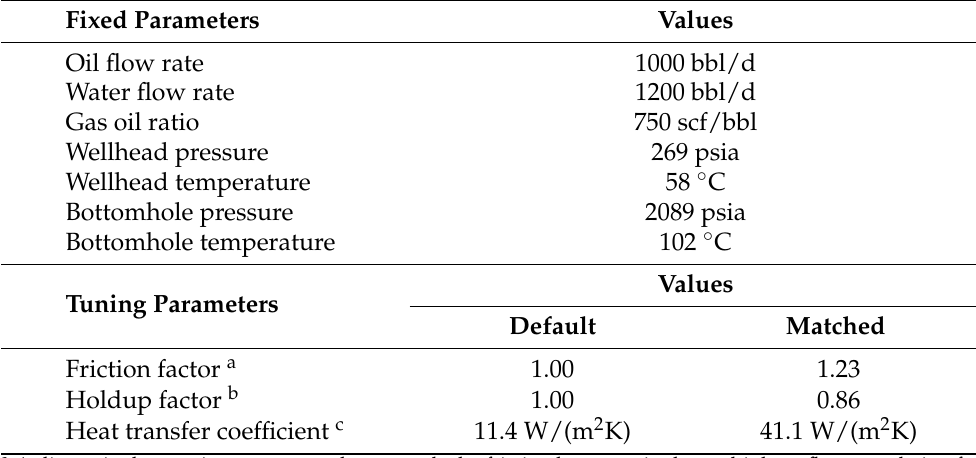
Table A3. Summary of the input data used for the modeling of the pressure and temperature in the wellbore.